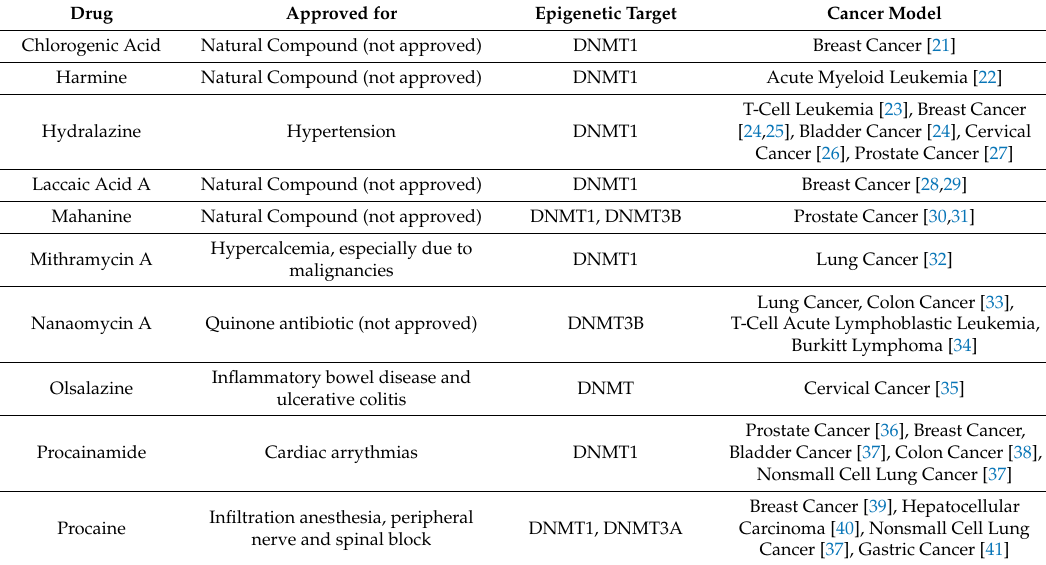
Table 1. Noncancer drug repurposing candidates for DNMT